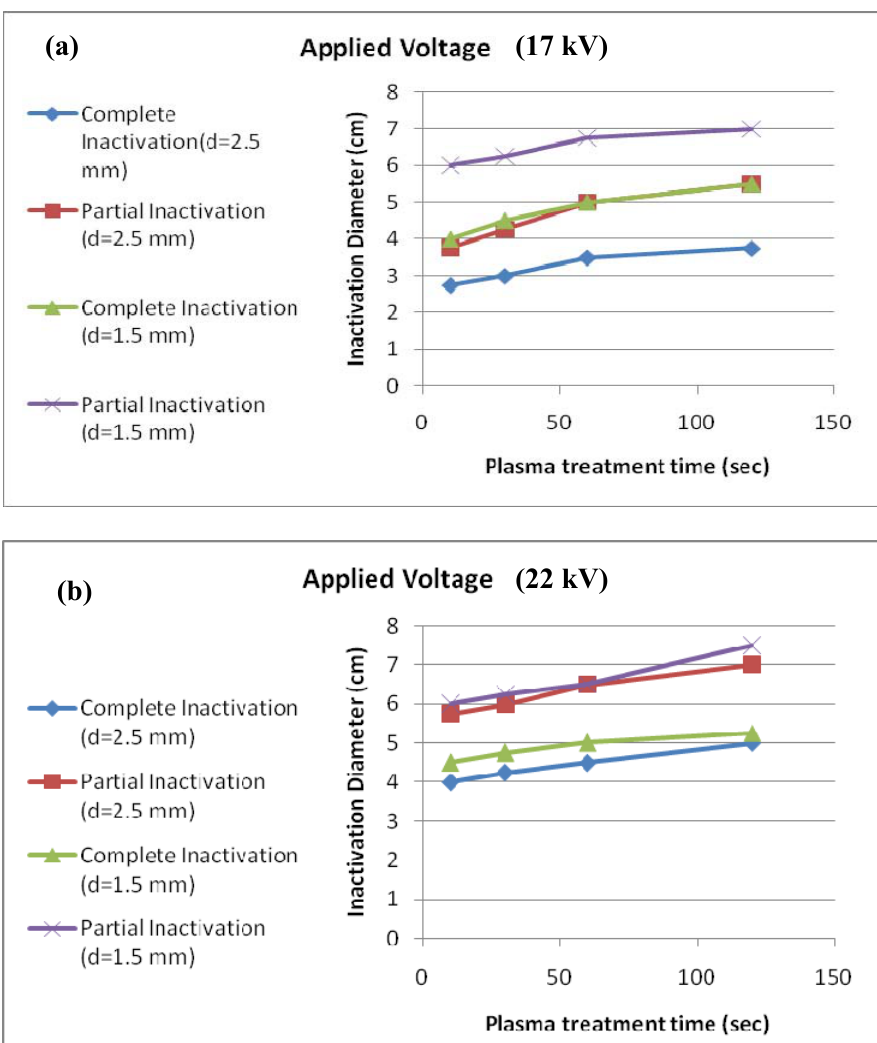
Fig. 4: The complete and partial inactivation diameter for E. coli bacteria as a function of the DBD plasma time treatment at 1.5mm and 2.4mm gap distance when the applied voltages are a) 17kV and b)